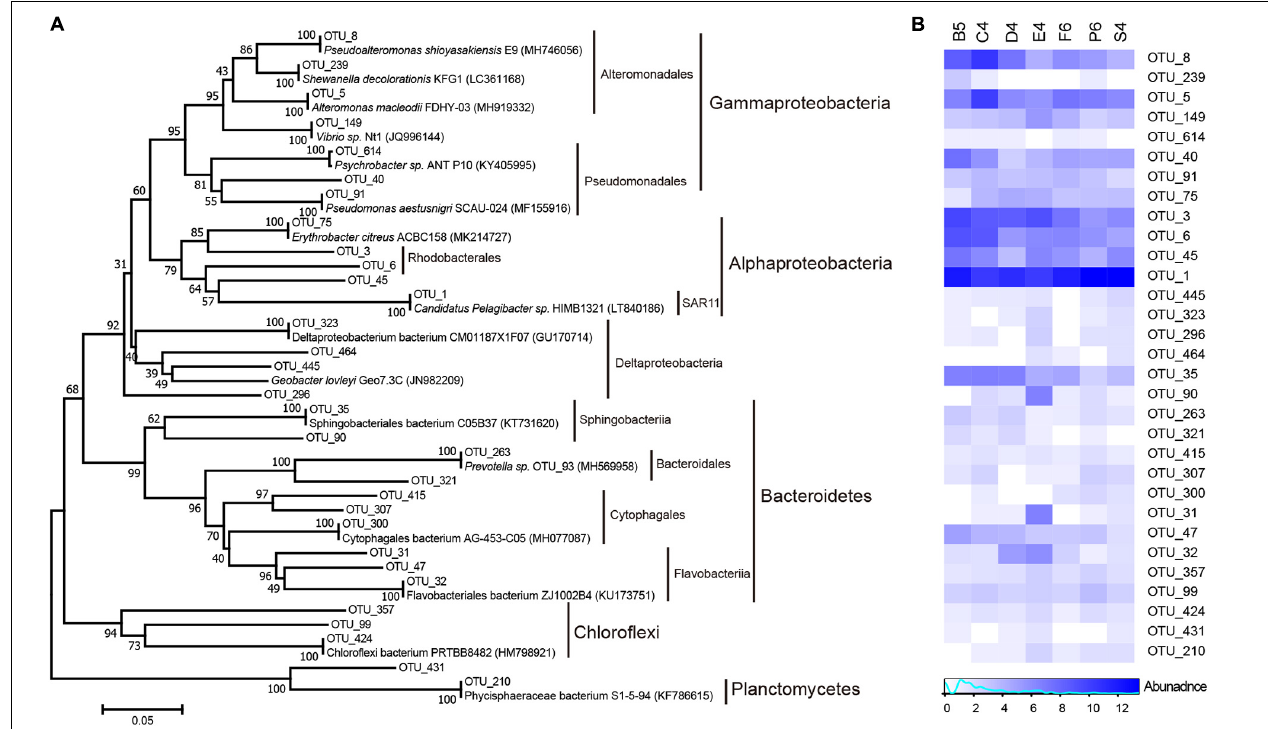
FIGURE 8 | Major producing enzyme clades in the north Chinese marginal seas. (A) Neighbor-joining phylogeny of bacterial phylotypes, based on partial 16S rRNA sequences. (B) Heatmap showing relative abundances for main microbes potentially producing various enzymes. Color bars represent the row-scaled value, in which a blue curve illustrates the distribution density